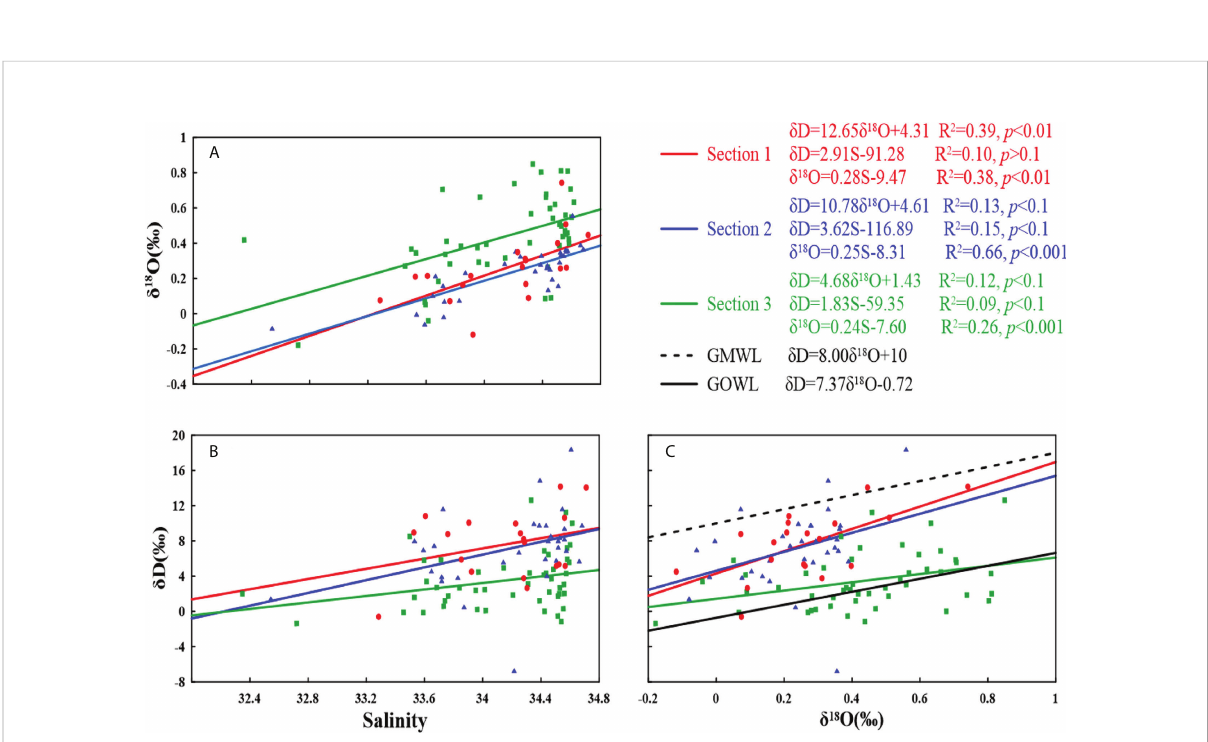
FIGURE 6 (A) d 18 O vs. salinity, (B) d D vs. salinity, and (C) d D – d 18 O relationship for selected sections as de fi ned in Figure 1. The GMWL was from Craig (1961); the GOWL was from Rohling